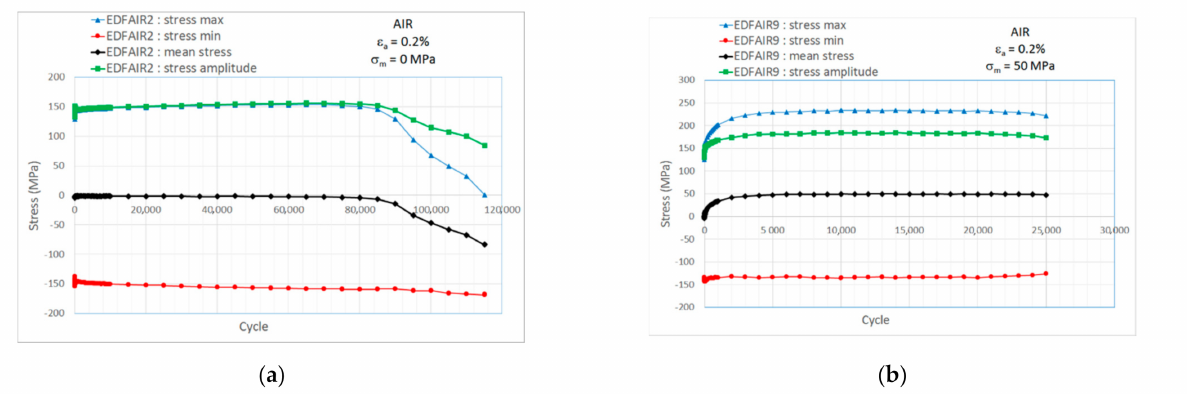
Figure 3. Stresses (min, max and amplitude) and the mean stress evolution versus cycle at ( a ) a nominal strain amplitude of 0.2% in air with σ m = 0 MPa; ( b ) σ m = 50 MPa (right); ε -control